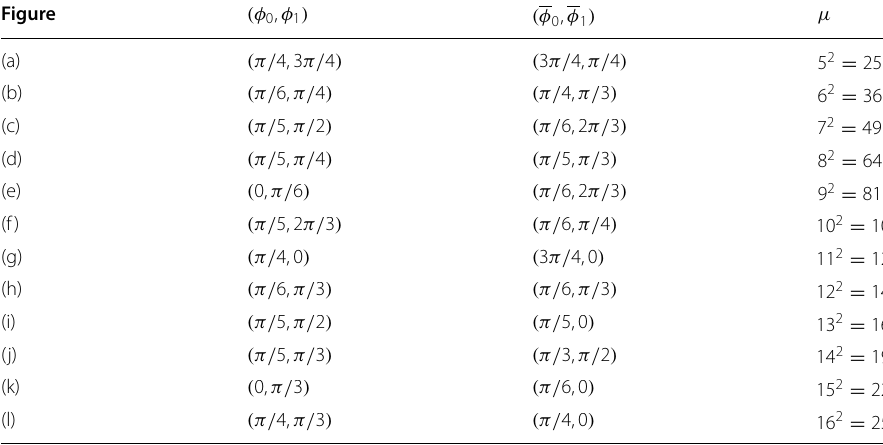
Table 3 Parameter selection under different scenarios in Fig. 5